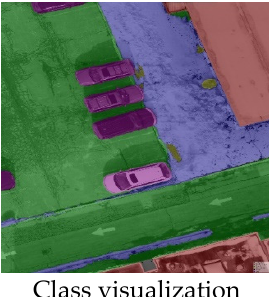
Figure 14. Labeled sample using Labelme software.